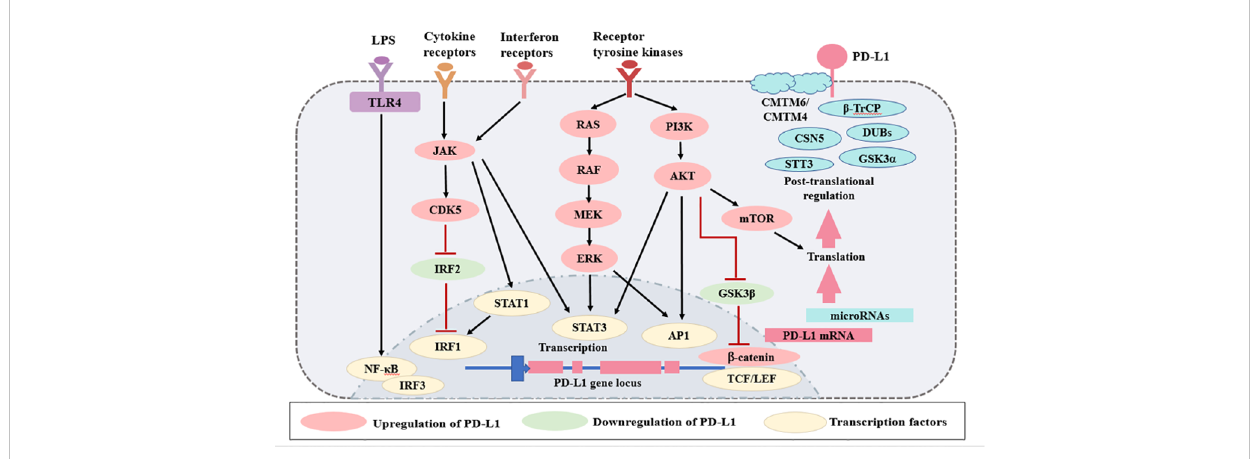
FIGURE 2 Regulation of PD-L1 expression. The expression of PD-L1 is regulated by several mechanisms. Various signaling pathways, such as TLRs, interferon receptors, cytokine receptors, and receptor tyrosine kinases, increase PD-L1 expression. There are several microRNAs that regulate PD-L1 mRNA transcription. Finally, PD-L1 is regulated at the protein level by protein circulation, ubiquitination, and glycosylation. Red lines represent inhibitory signals, and black lines represent stimulatory signals. AP1, activator protein 1; LPS, lipopolysaccharides; LEF, lymphoid enhancer- binding factor; TLRs, Toll-like receptors; NF- k B, nuclear factor k B; IRF, interferon regulatory factor; STAT, signal transducer and activator of transcription; TCF, T cell- speci fi c transcription factor; GSK3, glycogen synthase kinase 3; JAK, Janus kinase; CDK5, cyclin dependent kinase 5; CMTM, CKLF-like